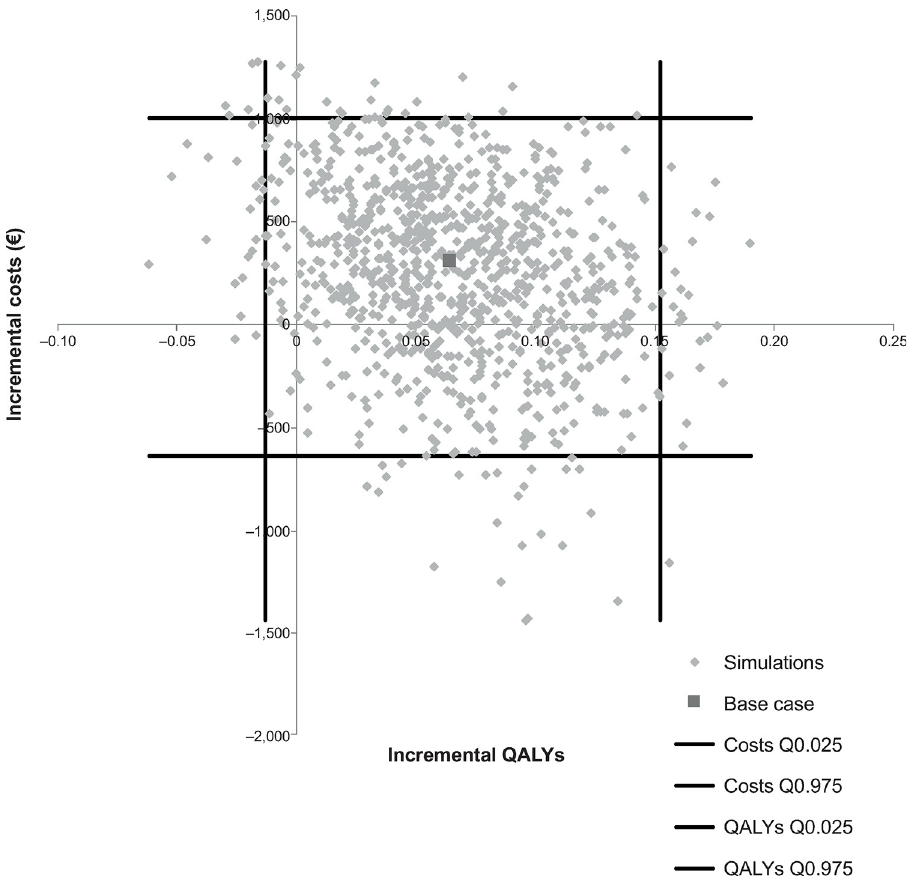
Fig 5. Dabigatran incremental cost-effectiveness plane. QALY, quality-adjusted life years.